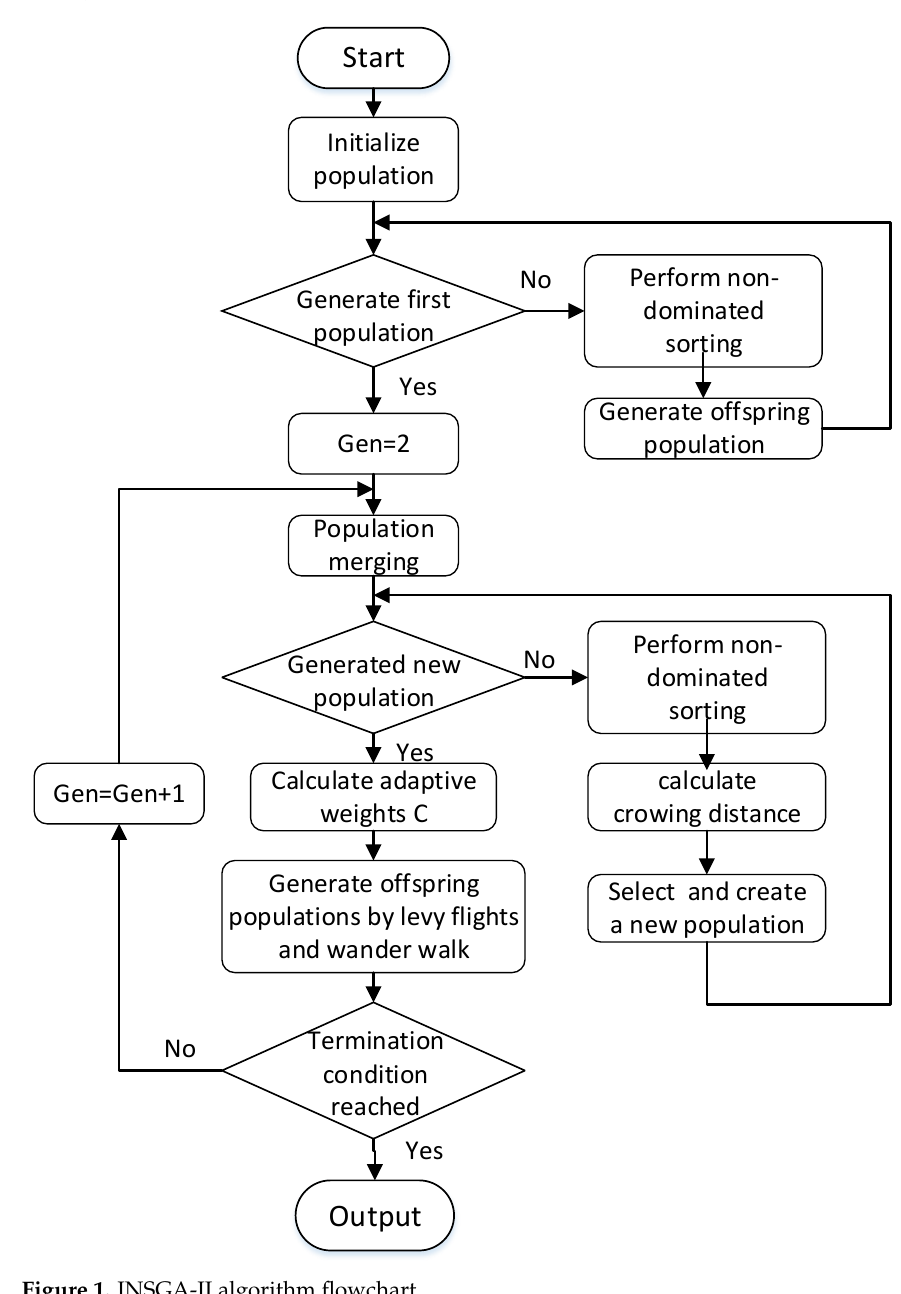
Figure 1. INSGA-II algorithm